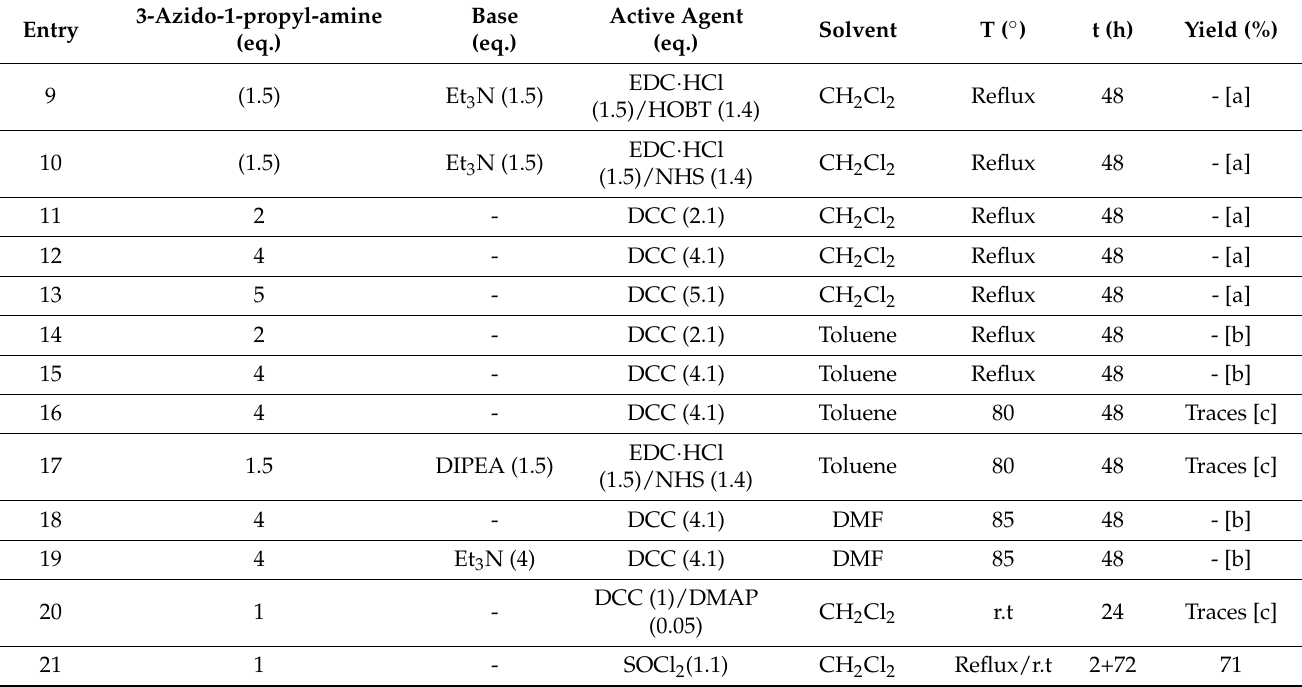
Table 1. Reaction condition used for the amidation reaction of